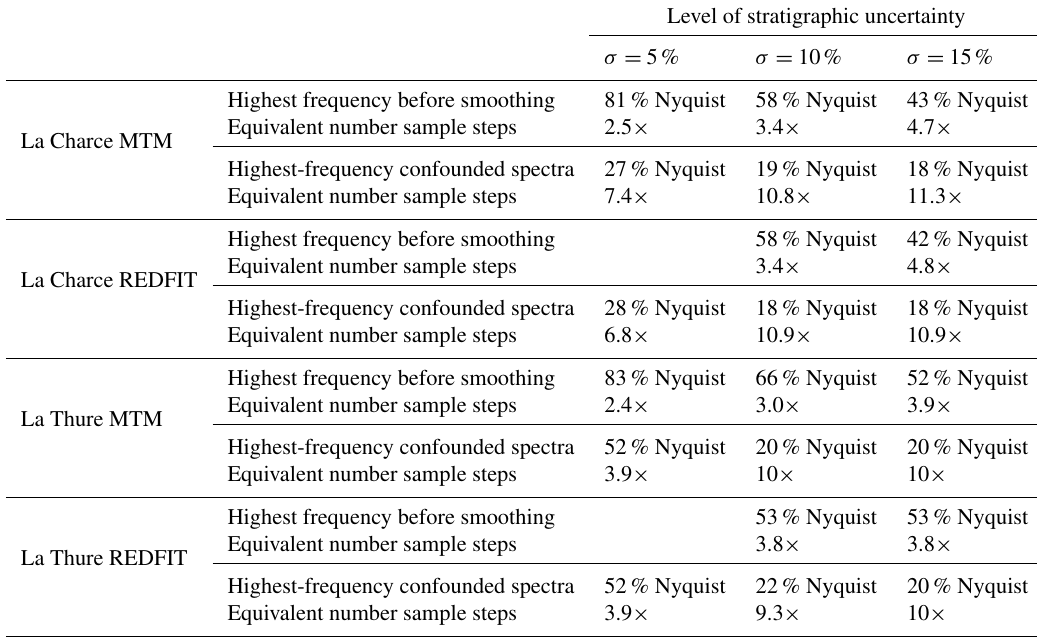
Table 2. Synthesis of the results of highest frequencies before smoothing of the spectra when applying the Monte Carlo simulations and of highest frequency at which the spectra before and after simulation are practically